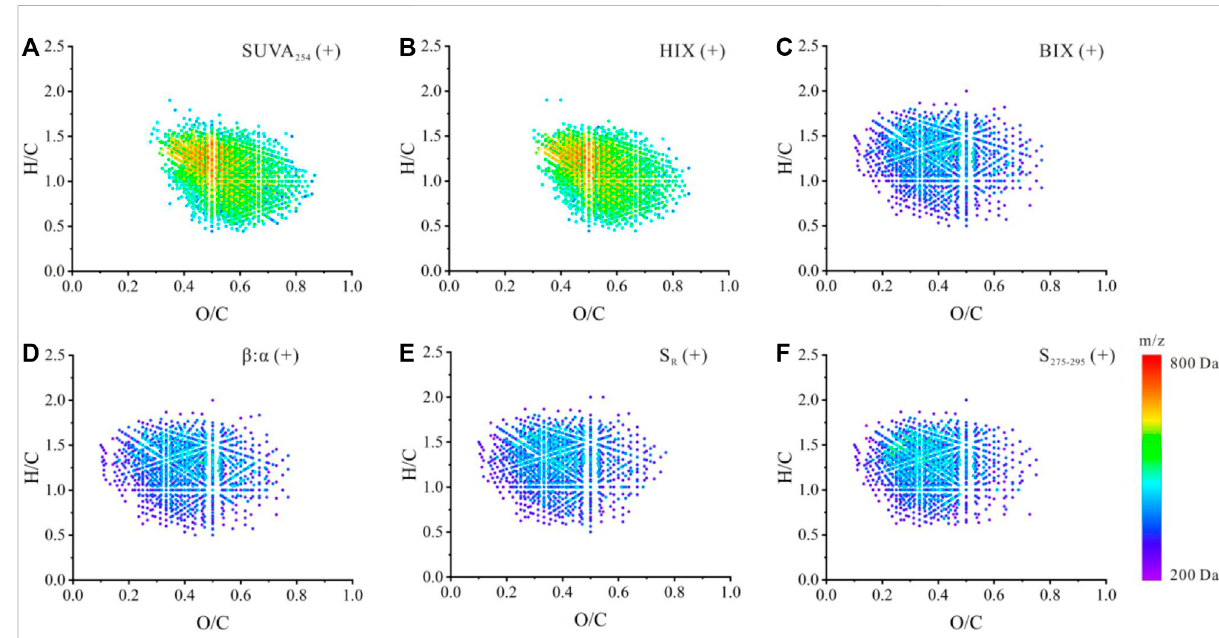
FIGURE 4 Van Krevelen distributions of molecular formulae positively correlated with optical properties. (A) SUVA254, (B) HIX, (C) BIX, (D) β : α , (E) SR (F)